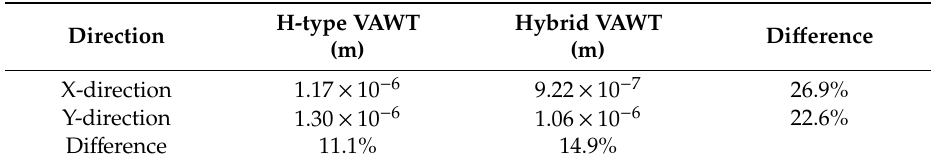
Figure 13. Forced transient responses of the 1 m-mast H-type and hybrid VAWTs in ( a ) X- and ( b ) Y-directions, and their steady-state responses in the ( c ) X- and ( d ) Y-directions from 6.5 to 8.5 s. Table 10. Comparison of the maximum steady ‐ state response amplitudes of the 1 m ‐ mast H ‐ type and hybrid VAWTs in X ‐ and Y ‐ directions.